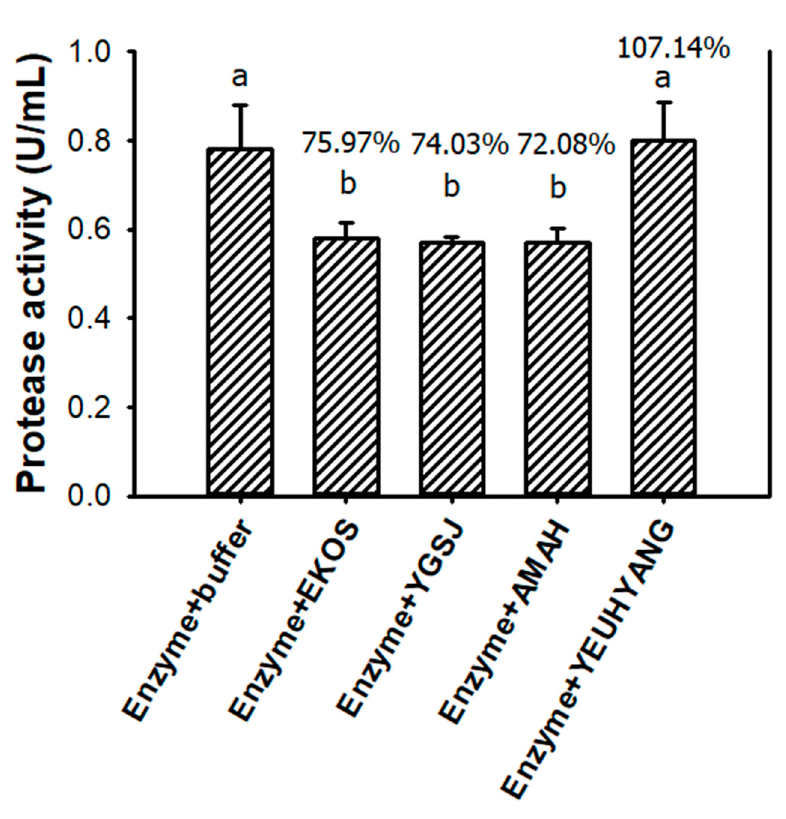
Figure 9. Compatibility of Paenibacillus sp. TKU047 protease with some commercial detergents (0.5%, w / v ). All points on the graph indicate the mean of each experiment (with n = 3) and standard deviation (error bar). Di ff erent letters (a and b) indicate significant di ff erence based on Turkey’s test with p < 0.05. The values on top of the bars (%) are the ratios of the residual activities to the protease activity of the enzyme in the phosphate bu ff